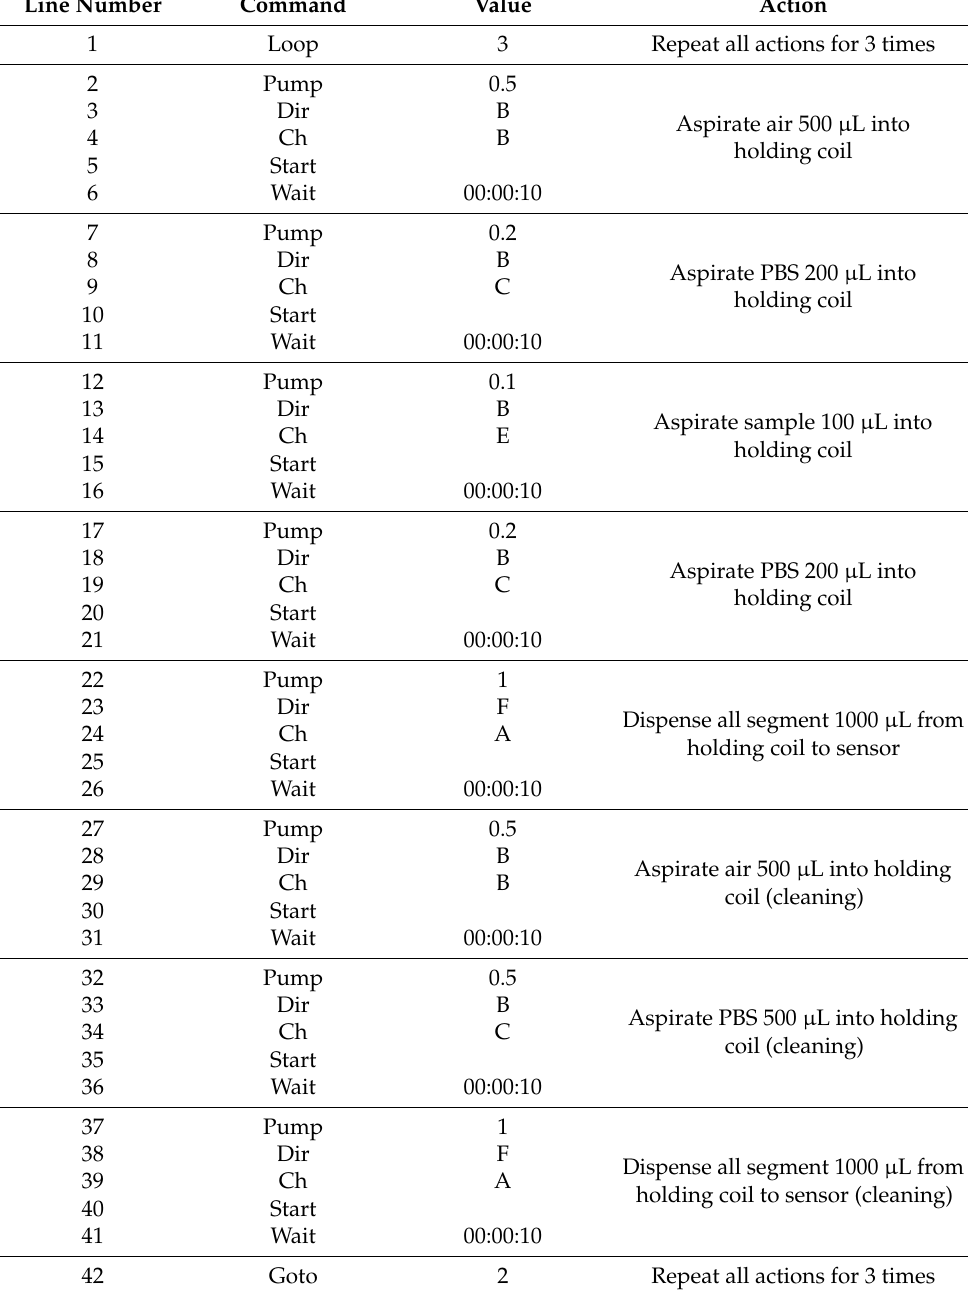
Table 4. A script for glucose analysis using the SI